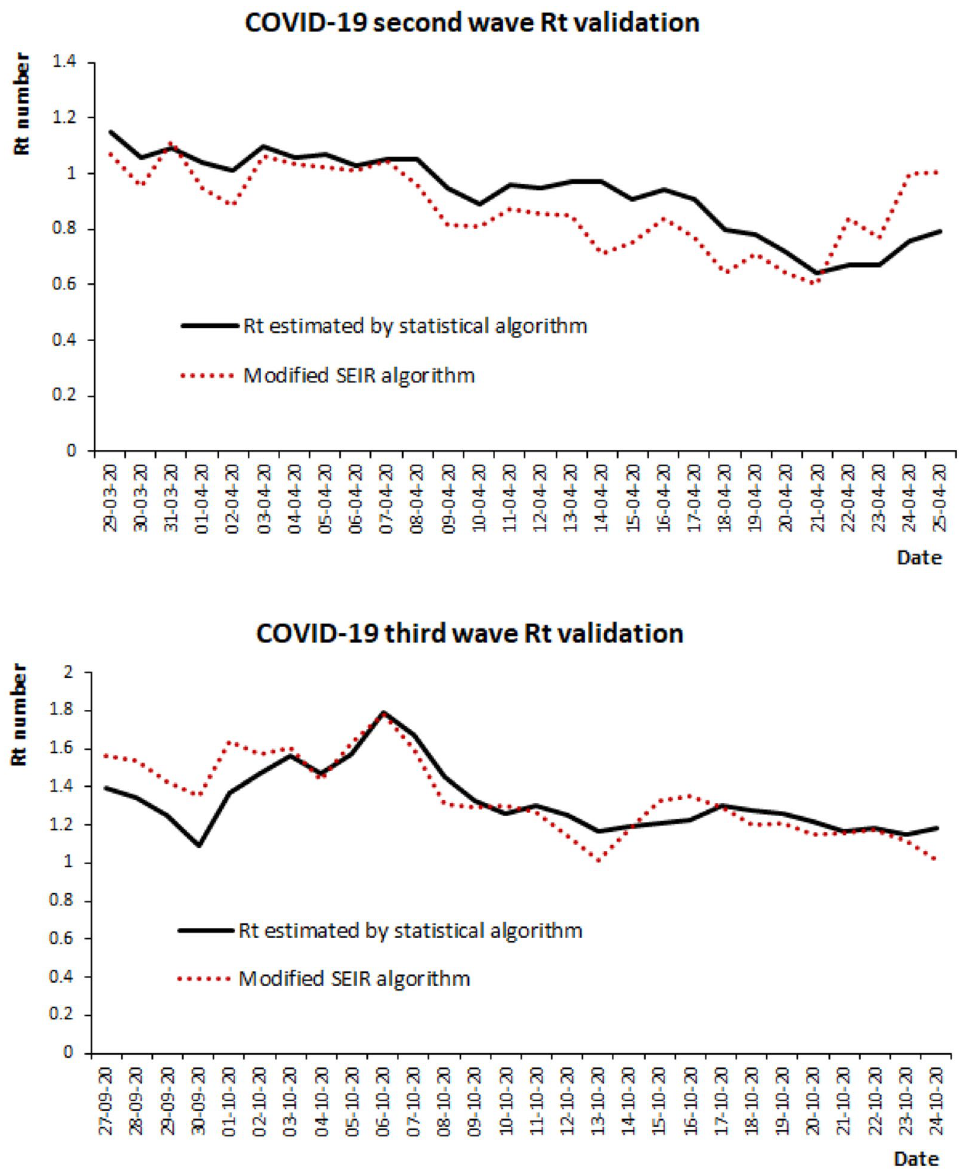
Figure 4. COVID-19 Second and Third wave Rt